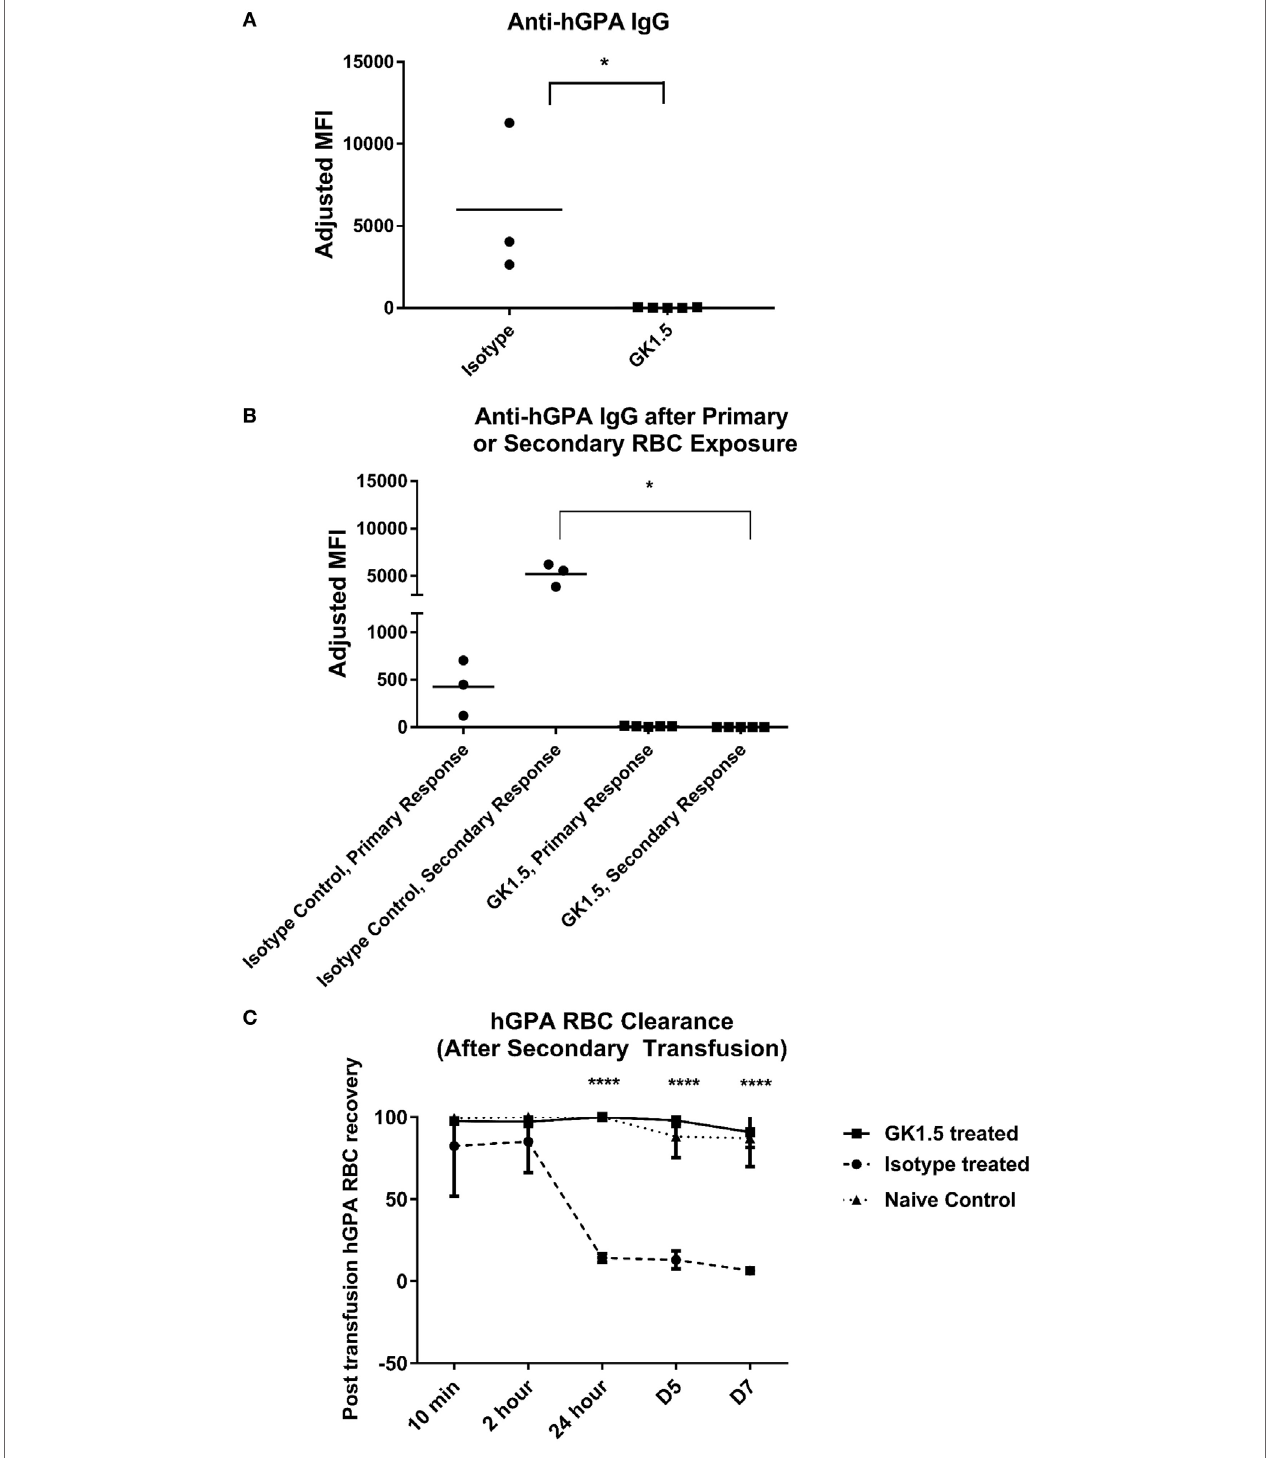
FigUre 2 | Alloantibody formation in the human glycophorin A (hGPA) RBC system is CD4 dependent. (a) Serum anti-hGPA IgG at day 14 represented as adjusted mean fluorescence intensity (MFI) in mice treated with GK1.5 or isotype-matched control antibody during primary transfusion. (B) Serum anti-hGPA IgG after primary or secondary hGPA RBC transfusion, with secondary transfusion given 5 weeks after primary transfusion and 3 weeks after last GK1.5 treatment. (c) Post- transfusion RBC clearance curve in GK1.5-treated, isotype-matched control antibody-treated, or naïve mice after secondary transfusion. * p < 0.05 determined by Mann–Whitney U test. **** p < 0.0001 determined by ANOVA between isotype control or naive and GK1.5-treated mice. There were no significant differences at any time point between naïve and isotype control mice. Data are representative of at least two experiments ( n = 3 to 6 mice per group per